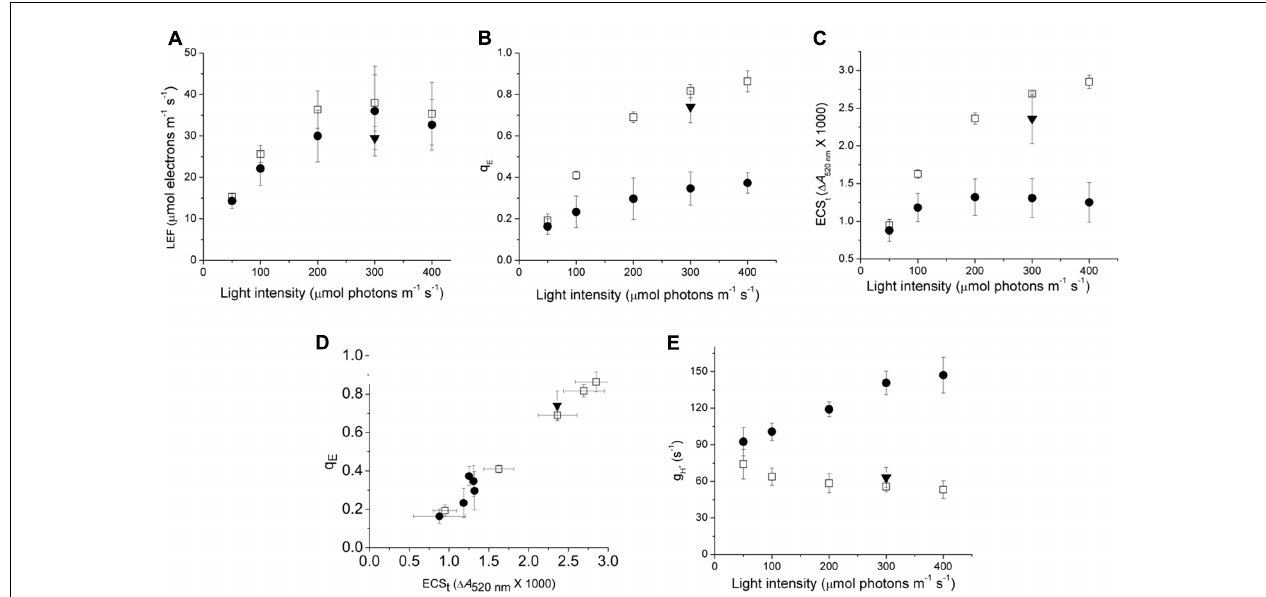
FIGURE 1 | Comparison of photosynthetic and photoprotective (q E ) responses of Col-0 and cfq under ambient CO 2 . Light dependence of linear electron flow (LEF, A ), the q E response (B) , the light-induced thylakoid pmf estimated by the ECSt parameter (C) ; the dependence of q E on the light-induced pmf , estimated by ECSt (D) , and the light intensity dependence of thylakoid membrane proton conductivity ( g H + , E ) reflecting ATP synthase activity. All experiments were conducted at 400 ppm CO 2 levels, allowing at least 30 min exposure to each condition before measurements. Symbols indicate Col-0 (open squares), cfq (closed circles) and comp (35S::atpC1, closed triangles).